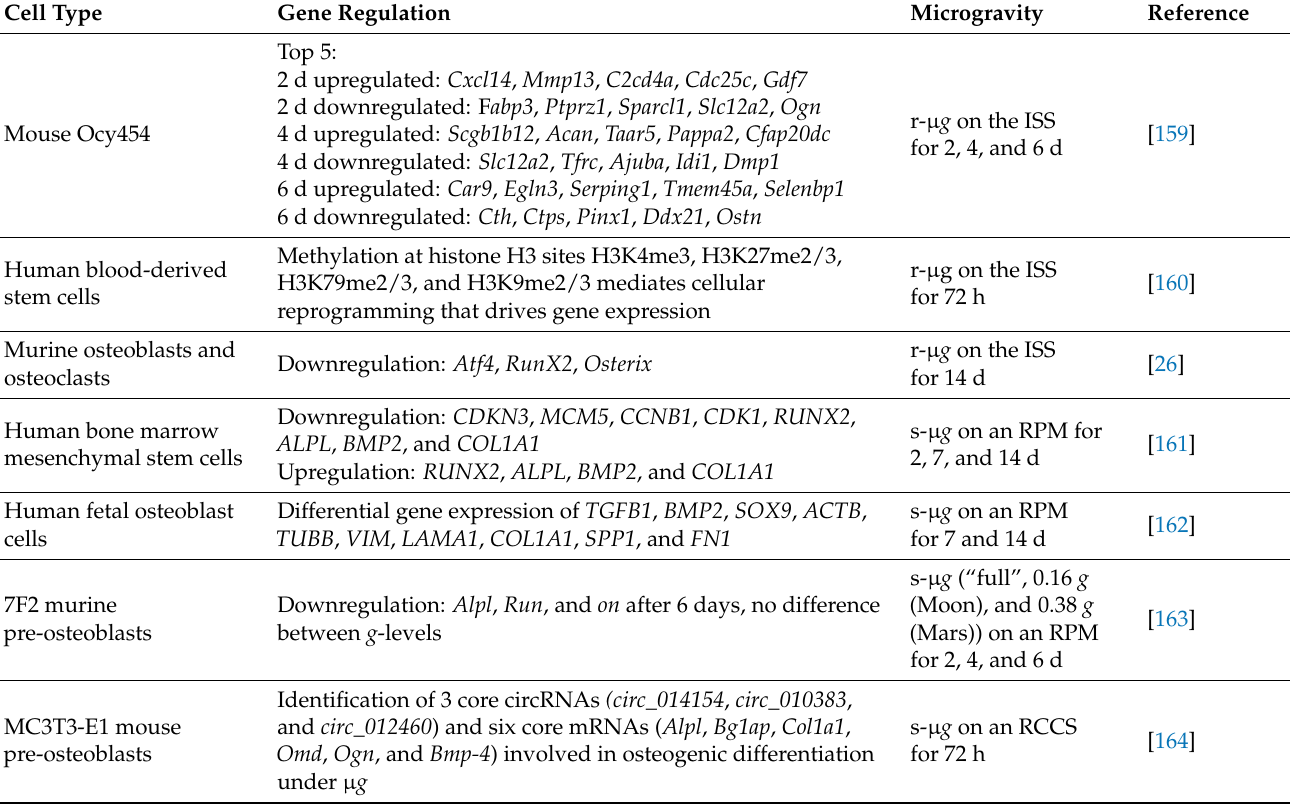
Table 8. Changes in gene regulation of bone cells exposed to microgravity